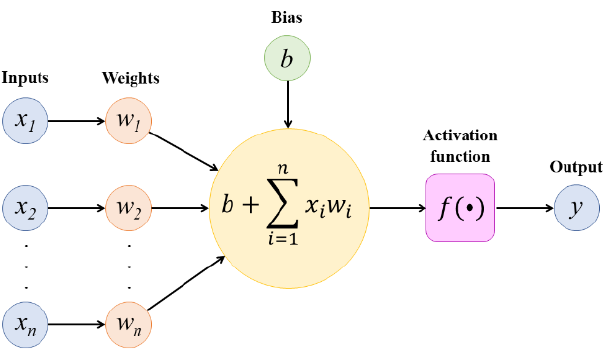
Figure 15. Application of an activation function between the nodes of successive network layers. The Rectified Linear Unit (ReLU) and Leaky ReLU activation functions, which are used in the encoder and de-coder sections of the CNNs, respectively, are depicted in Fig- ure 16. In this work, the Leaky ReLU function is applied with a constant slope a of 0.2.